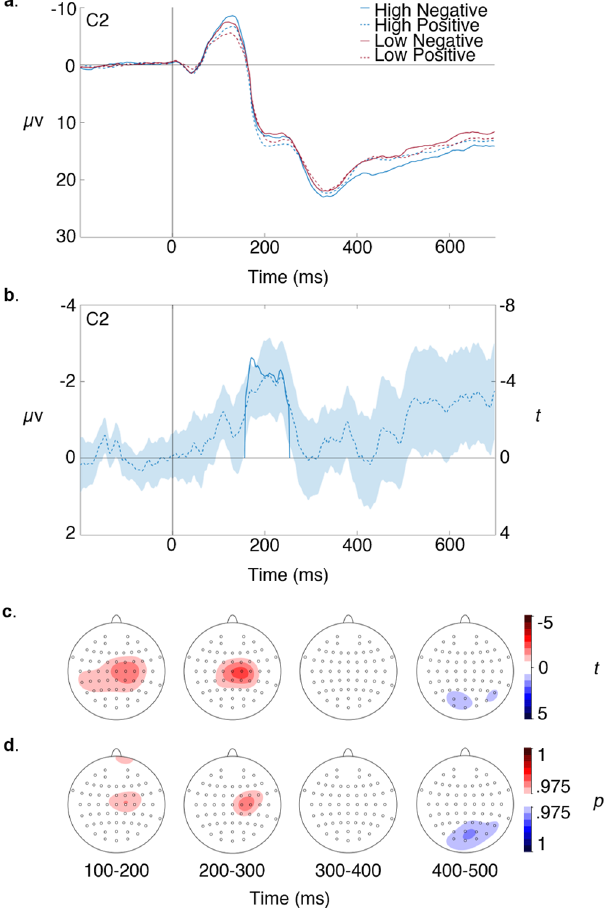
Figure 2. ( a ) Simple waveforms. ( b ) FRN (i.e. LN–HP difference wave) expressed as voltage (dotted line) and thresholded t statistic over participants (bold line), with shading showing two standard errors of the mean. ( c ) Scalp topography of the thresholded FRN t statistic showing areas where increased RPE value is encoded with positive voltage (red) and negative voltage (blue). ( d ) Scalp topography of thresholded Bayesian contrasts showing same effects. All plots were created in MATLAB version 2020a (https:// uk. mathw orks. com/ produ cts/ matlab.